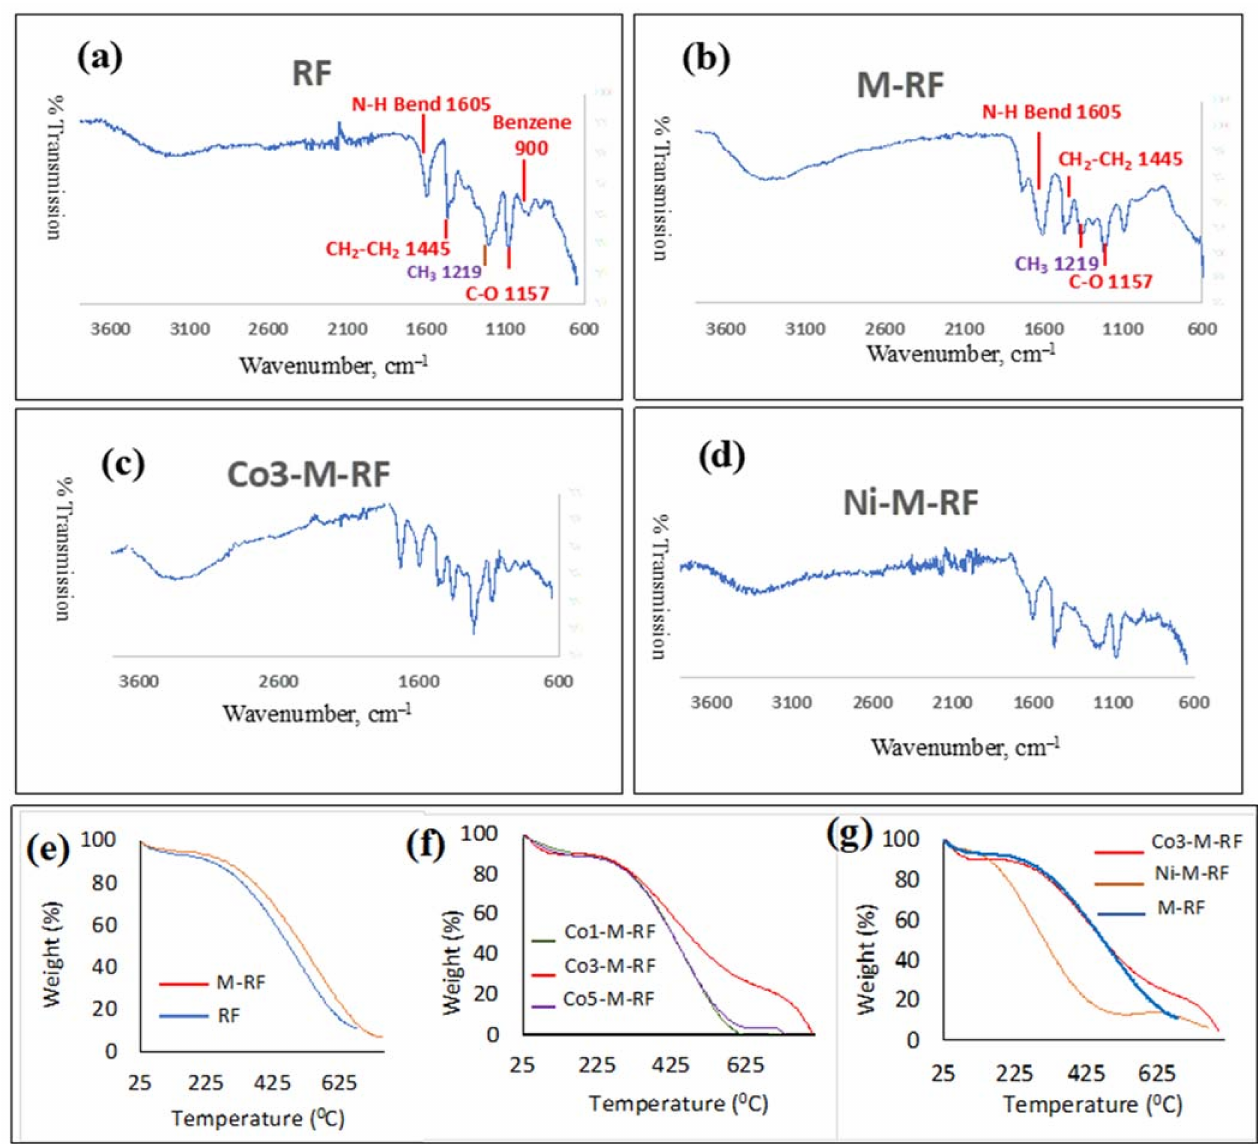
Figure 1. FTIR spectra ( a ) RF resin ( b ) Mesoporous catalyst without metal centers ( c ) MRF with 3%Co (Co2-M-RF) ( d ) MRF with Ni (Ni3-M-RF), Thermogravimetric Analysis ( e ) RF and MRF without metal centers ( f ) MRF with progressively increasing Co content ( g ) Comparison of MRF with MRF-3% Co and MRF with